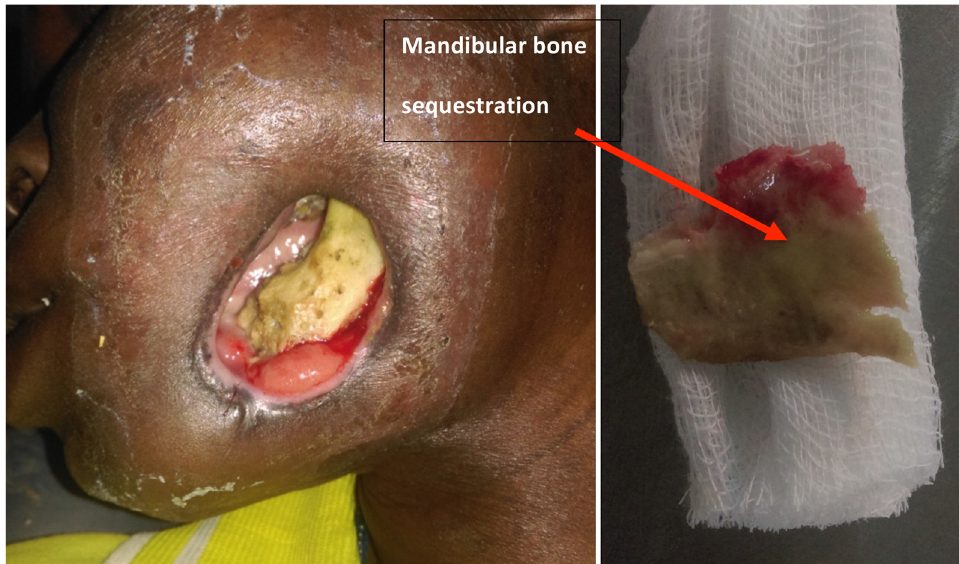
Fig. 4. Wound appearance on the 30th day of hospitalization, demonstrating an orostoma and a mandibular bone